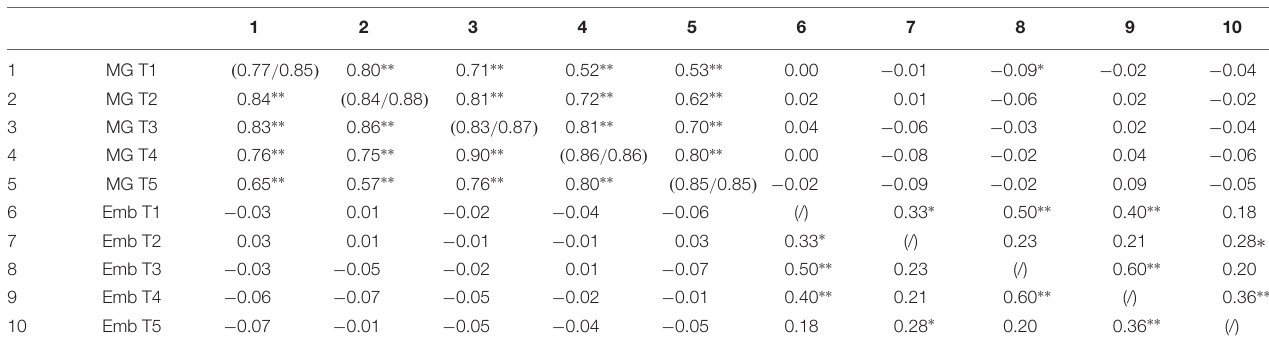
TABLE 2 | Summary statistics for mastery goals Mathematics and English (latent level).